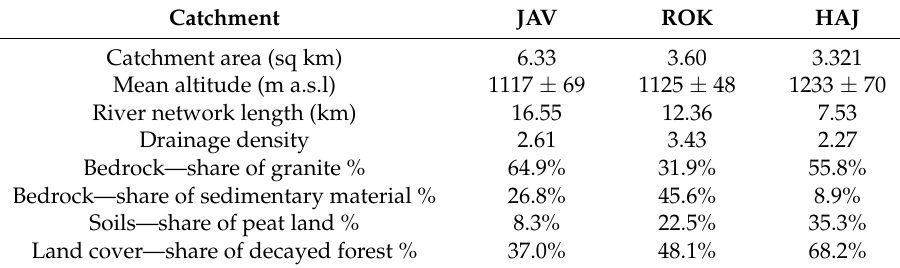
Table 1. Physiographic properties of the experimental headwater catchments. Data: Czech Hydrometeorological Institute (CHMI), Czech Geological Service (CGS), Forest Management Institute (FMI) and Charles University (CUNI).